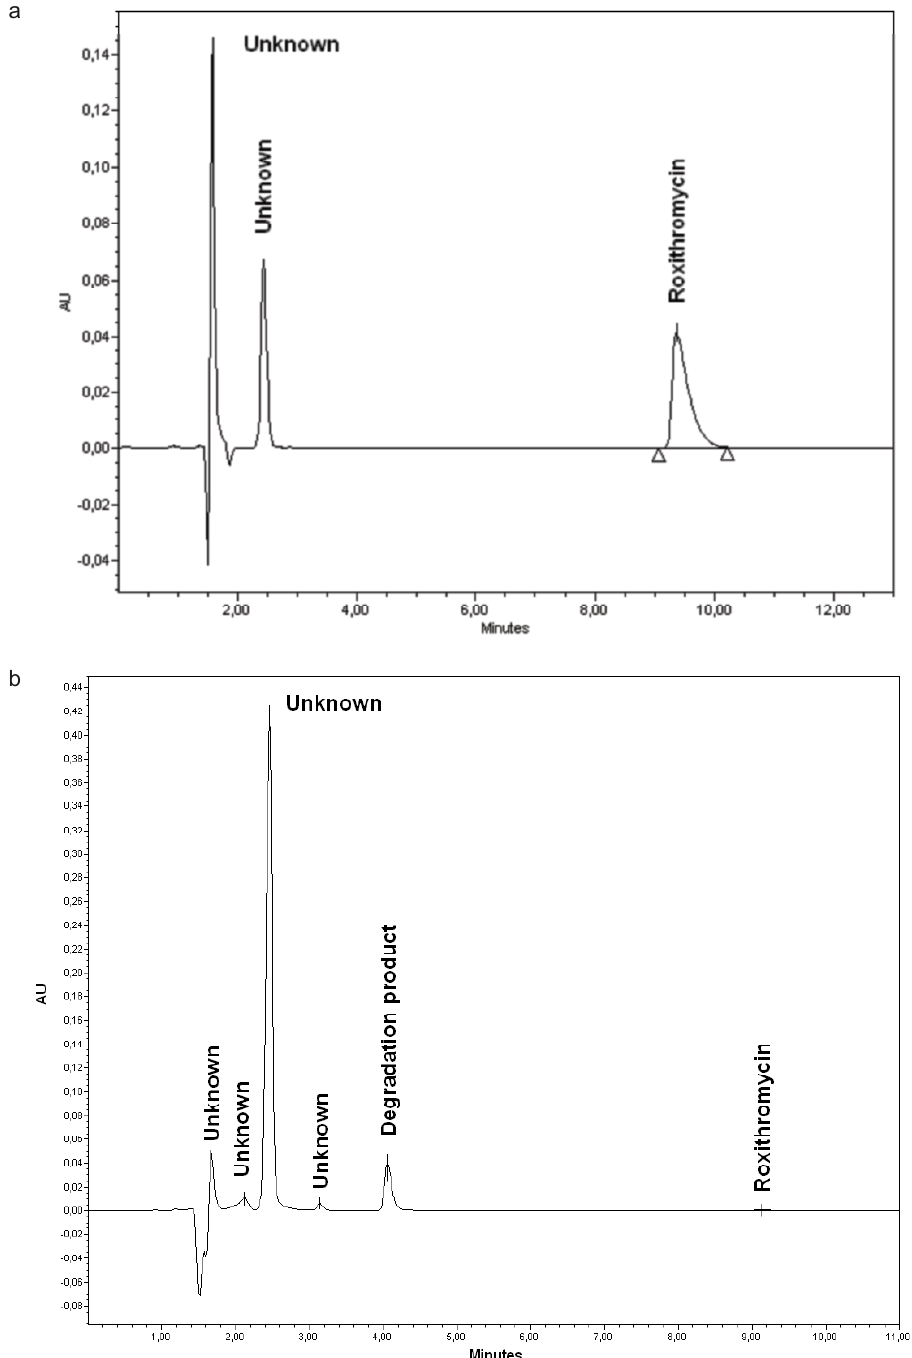
Figure 2. The example of chromatogram showing peaks of: a) roxithromycin (with retention time, t (with retention time, t , equaled 4.05 R